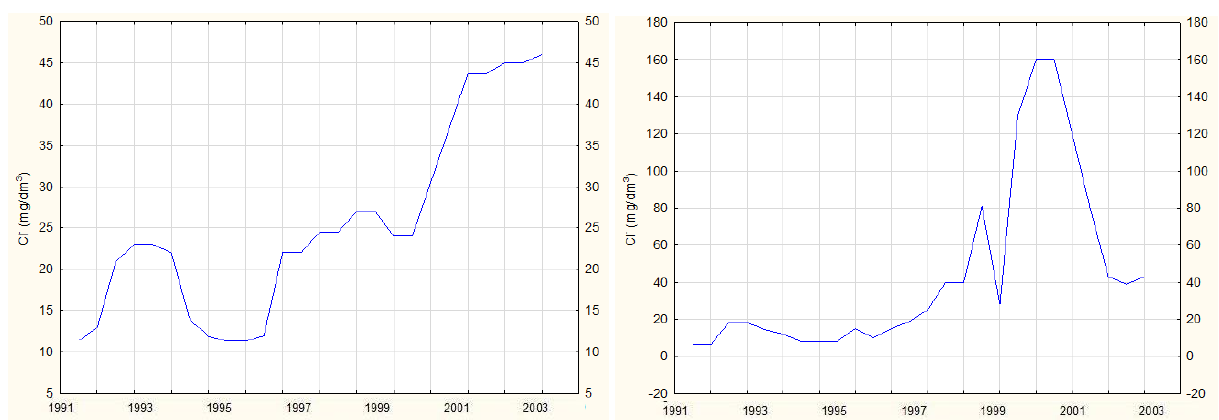
Fig. 3. Changes in chloride content in piezometers T1 and Q1 obtained with the moving average method